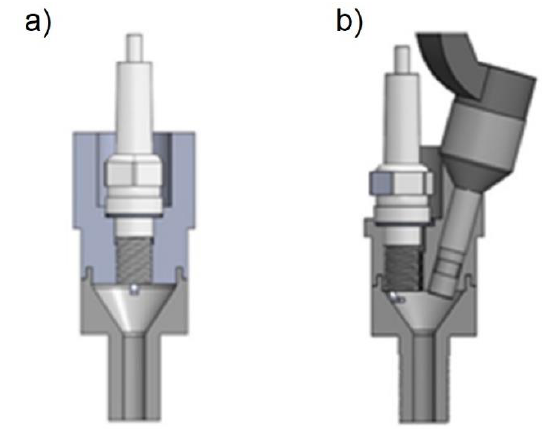
Fig. 6. Prechambers used in SI engines: a) passive prechamber; b) active prechamber [1]